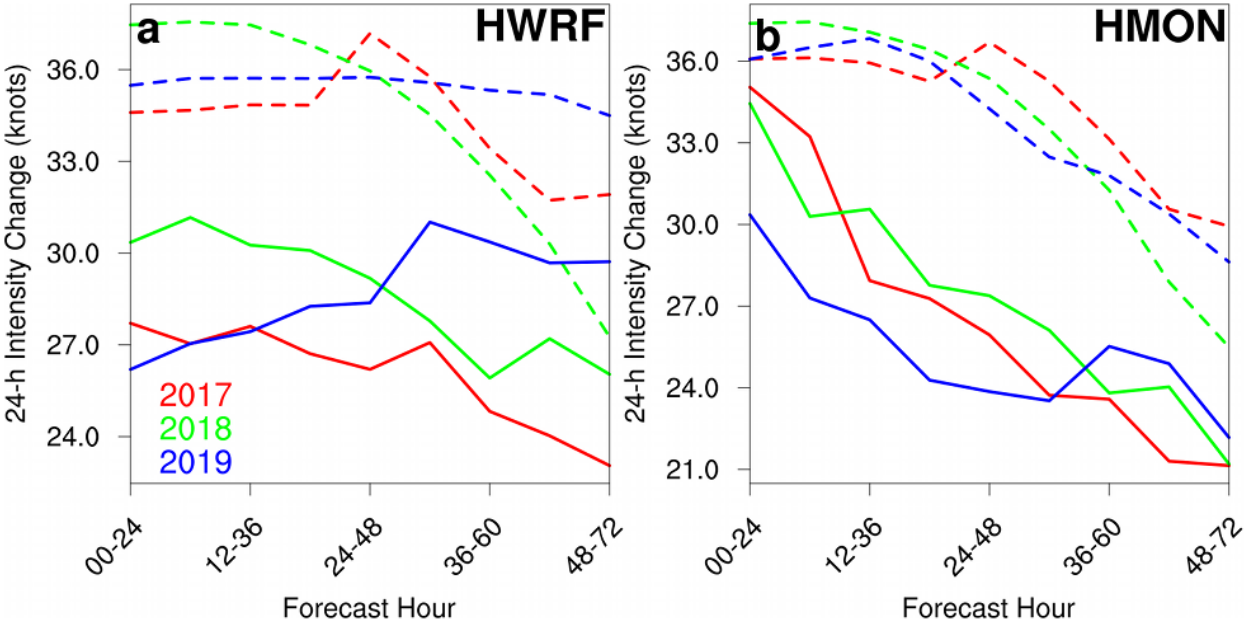
Figure 2. ( a ) HWRF 95th percentile 24-h TC maximum wind speed changes (solid line) based on retrospective forecasts prior to the 2017 (red), 2018 (green) and 2019 (blue) seasons as a function of forecast lead time. The dashed lines indicate the corresponding best track TC maximum wind speed changes for those years. ( b ) as in ( a ), but for the HMON